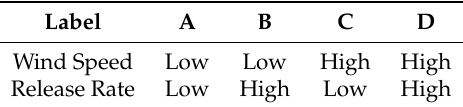
Table 1. Environmental condition setups.